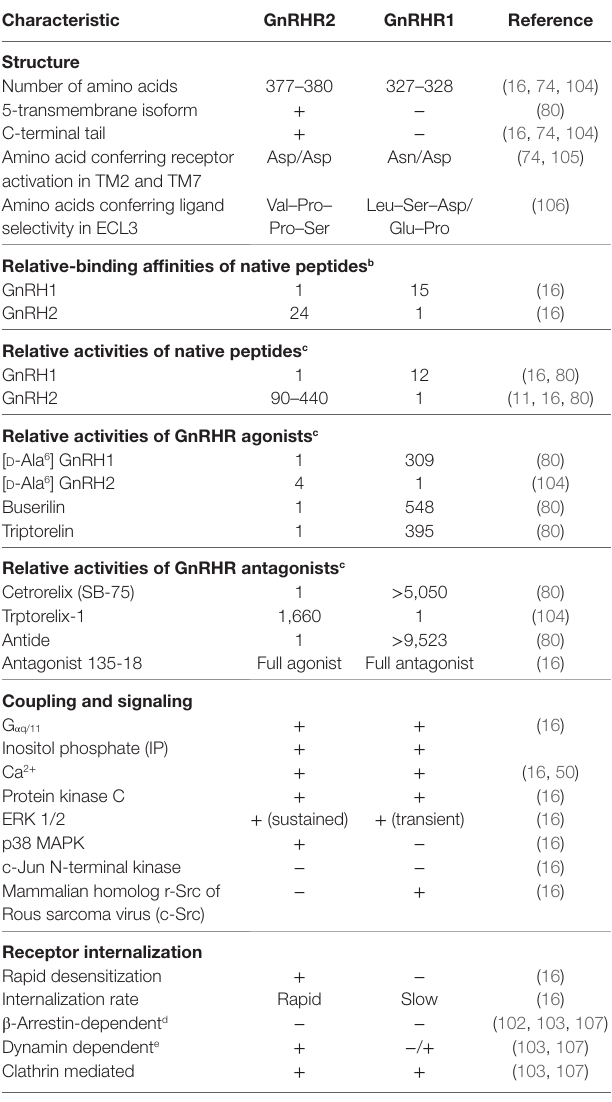
TABLe 6 | Structural and functional characteristics of GnRHR1 and GnRHR2 in mammals.